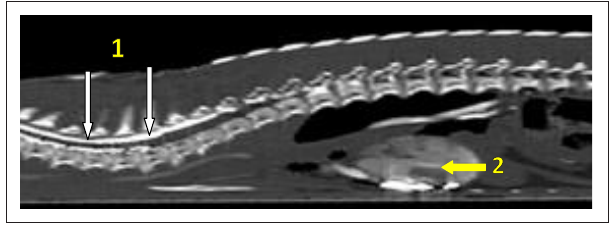
FIGURE 3: Sagittally reconstructed computed tomography image following the administration of contrast medium into the post-occipital venous sinus.